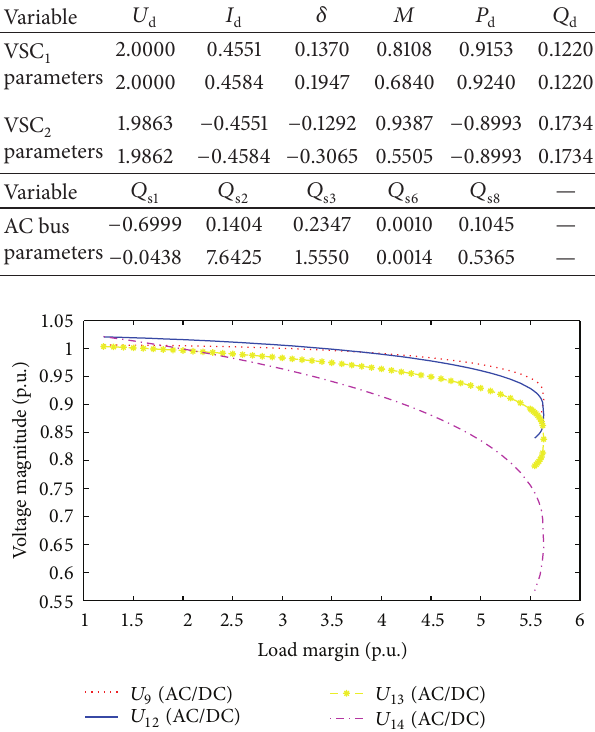
Figure 4: PV curves for modified IEEE-14 bus system in operating mode “1.”